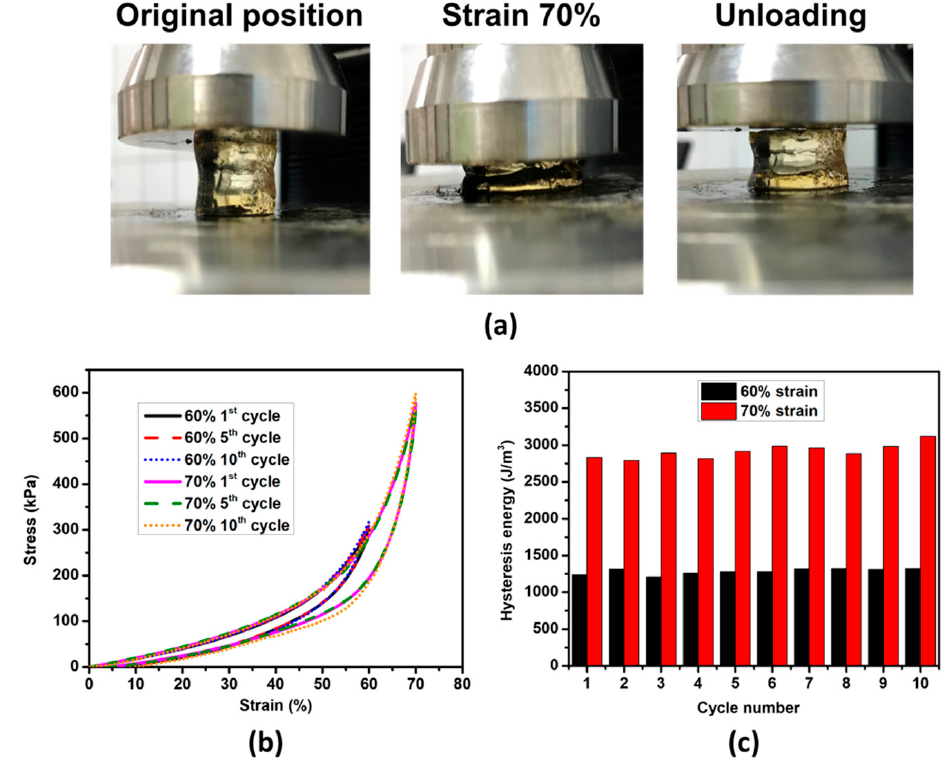
Figure 2. Dynamic mechanical behaviors of the pTMAEMA-PA hydrogels at a different loading concentration of phytic acid (PA): ( a ) angular frequency dependence of the storage modulus G ′ , loss modulus G ″ , and ( b ) loss factor tan δ .